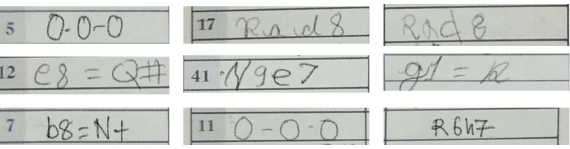
Figure 13. Samples from the less frequent moves dataset. These images are not taken from real games, rather created artificially with the help of volunteers. This is also a part of the HCS